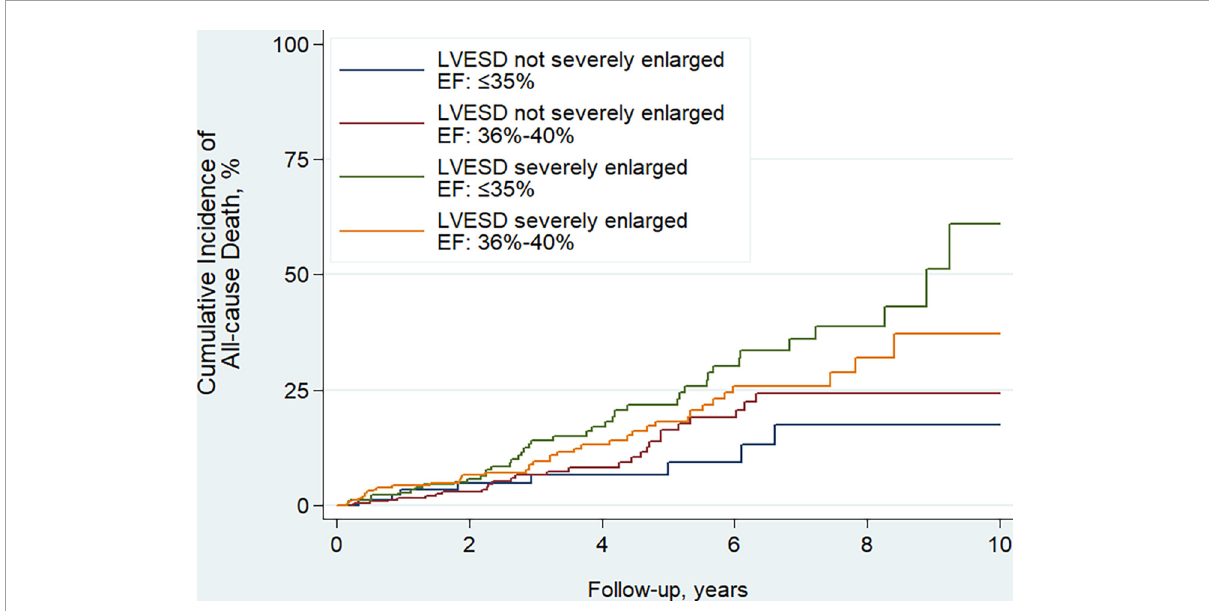
FIGURE4 Kaplan–Meier curves estimating incidence of all-cause death after revascularization among 4 patient groups according to whether LVESD was severely enlarged or not, and EF ≤ 35% or of 36–40% at baseline. Men with LVESD ≥ 46 mm and women with LVESD ≥ 42 mm were defined as severely enlarged LVESD. LVESD, left ventricular end-systolic diameter; EF, ejection